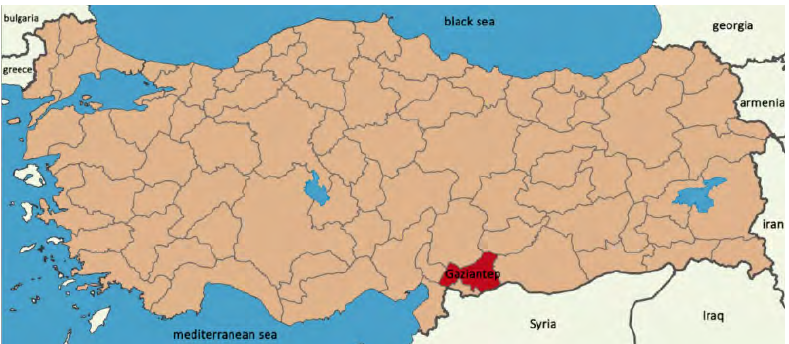
Figure 1. (a): Location of Gaziantep